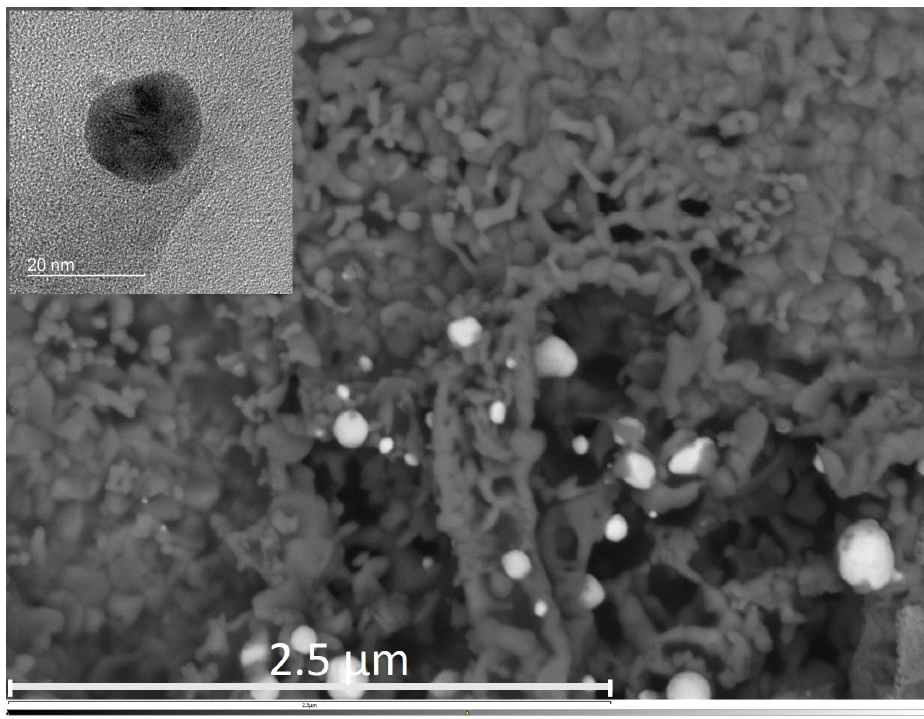
Figure 3. SEM image of the investigated sensor surface area containing Au nanoparticles. The insert shows a TEM image of a single nanoparticle.